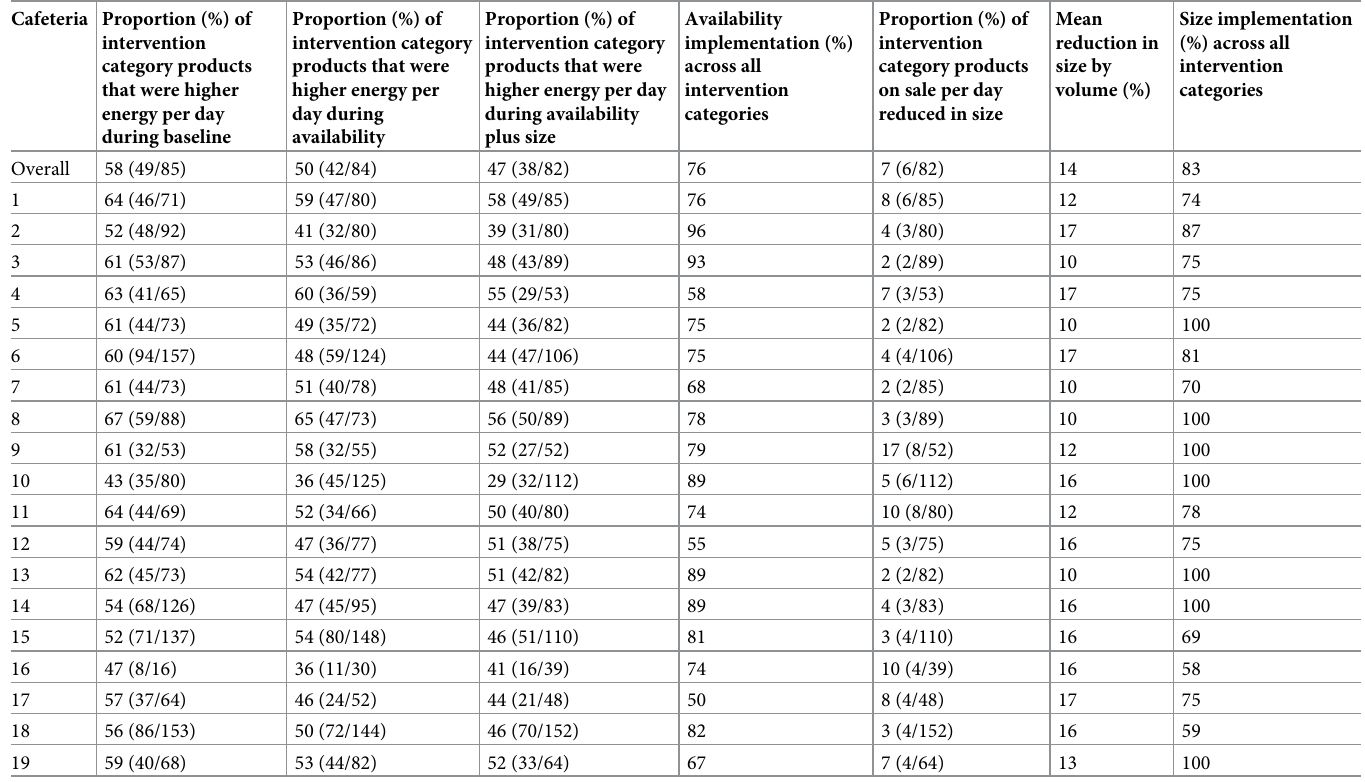
Table 2. Intervention